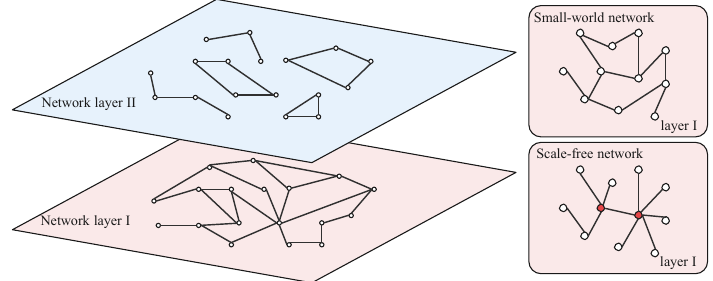
Figure 2. Asymmetric competitive and cooperative double-layer network.